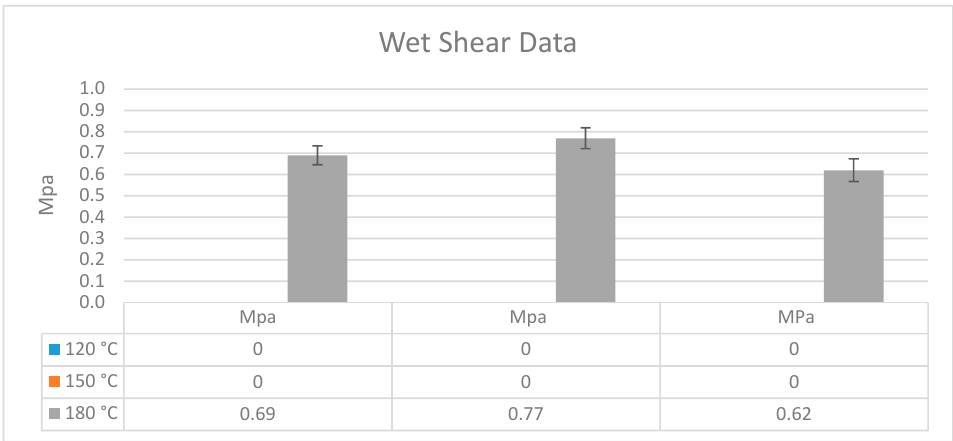
Figure 5. Dry and wet shear strength for three samples of CSPI bonded three-ply plywood.